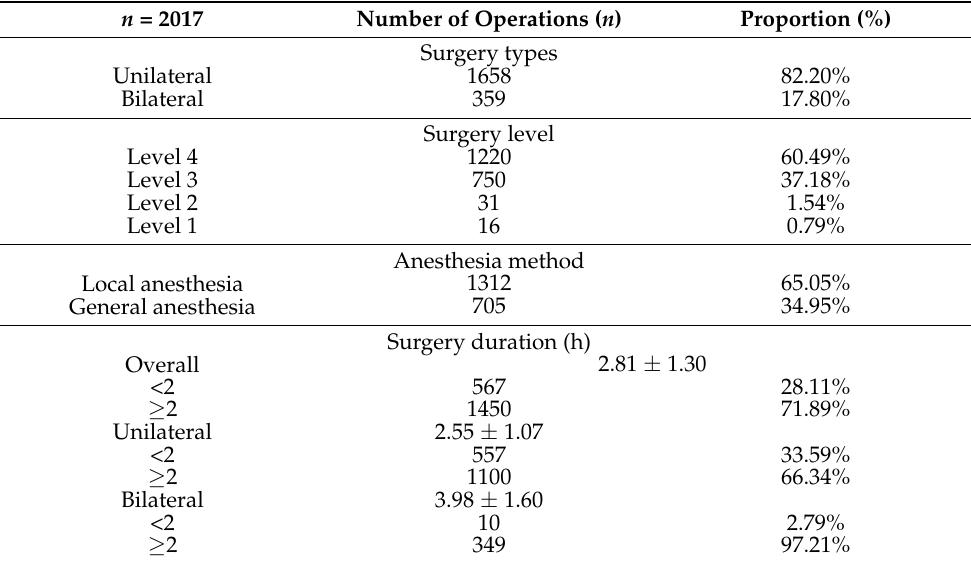
Table 2. Surgical characteristics of TKA patients ( n =